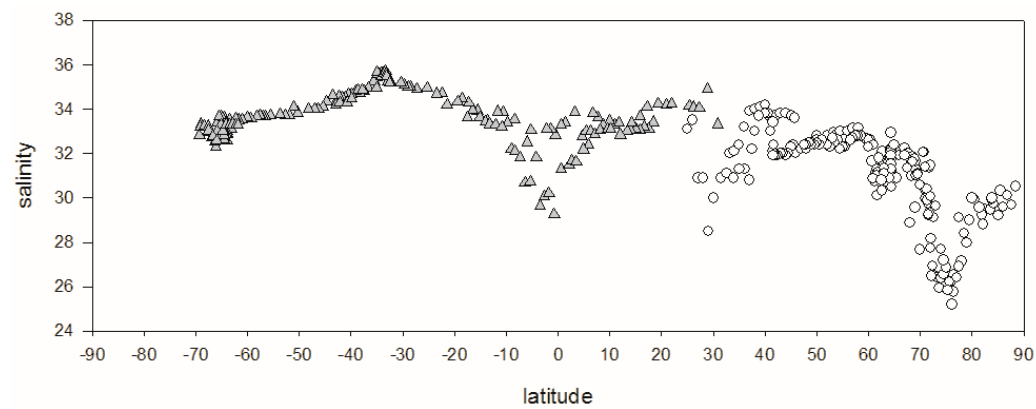
Figure 6. Surface salinity along the cruise tracks of the 4th Chinese National Arctic Research Expedition (empty circles) and the 27th Chinese Antarctic Research Expedition (gray triangles). Low salinity is identified near the Equator, at 30° N and at 75° N. The first two low salinity regions are influenced by river runoff, and the third may be influenced by ice melt water and river runoff.